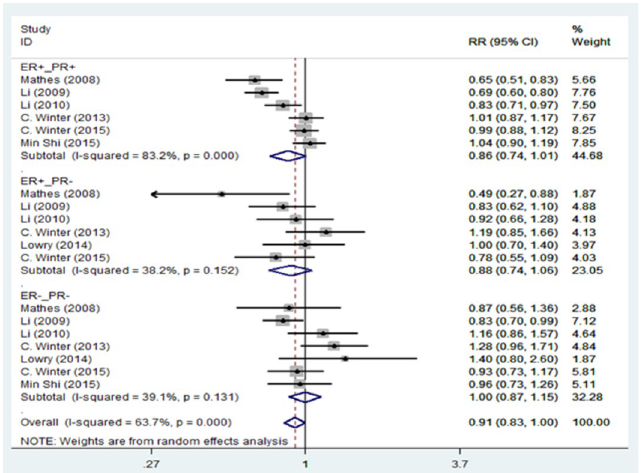
Fig 4. Forest plot of the association between migraine and breast cancer by hormone receptor status. CI = confidence interval; ER = estrogen receptor; PR = progesterone receptor; RR = relative risk.